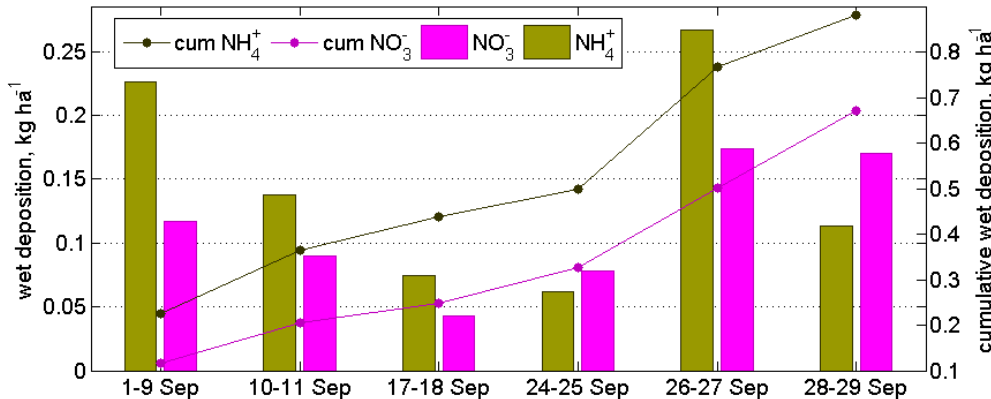
Fig. 7. Wet deposition of NH + and NO − in September 2007 at the Weidenbrunnen site. Indicated are wet deposition amounts per event (in 4 3 kgha − 1 in terms of N, left scale) and cumulative (cum) values for the entire month September 2007 (right